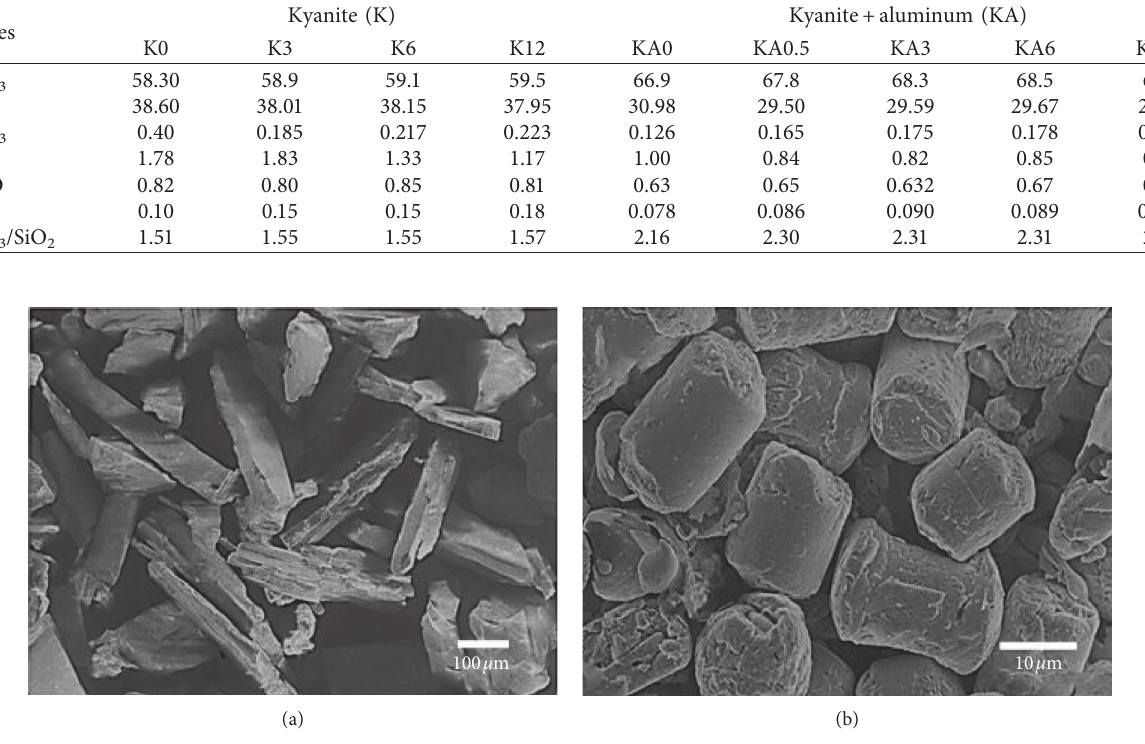
Figure 2: SEM images of raw kyanite (a) and aluminum powder (b). Figure 5; it can be observed that no reaction occurred during the milling 5(a) as peak patterns of milled samples are basically overlapping peaks in the XRD patterns of the unmilled samples.